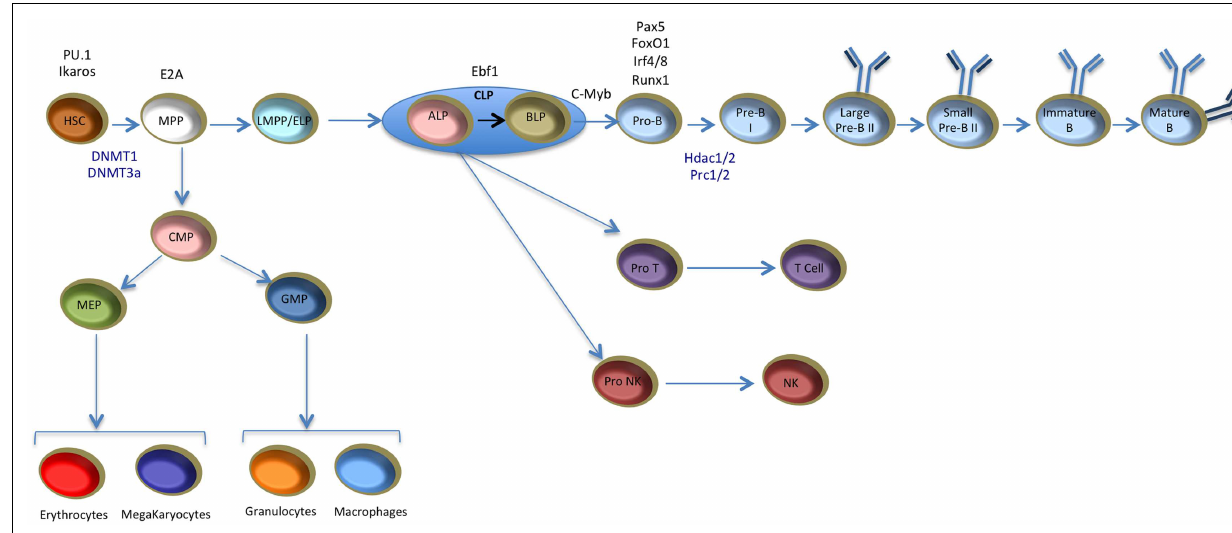
common lymphoid progenitors; ALP, all lymphoid progenitors; BLP, B cell-biased lymphoid progenitor; Pro NK, progenitor natural killer cells;